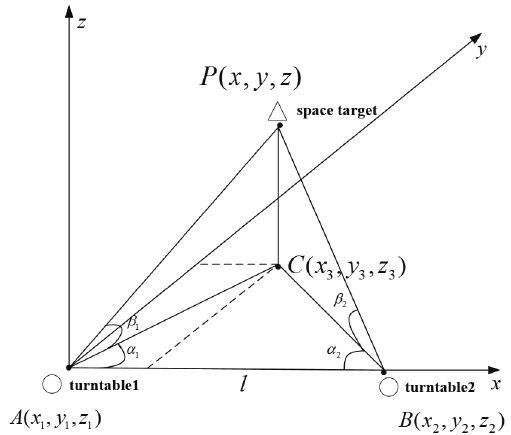
Figure 7. The trajectory measurement